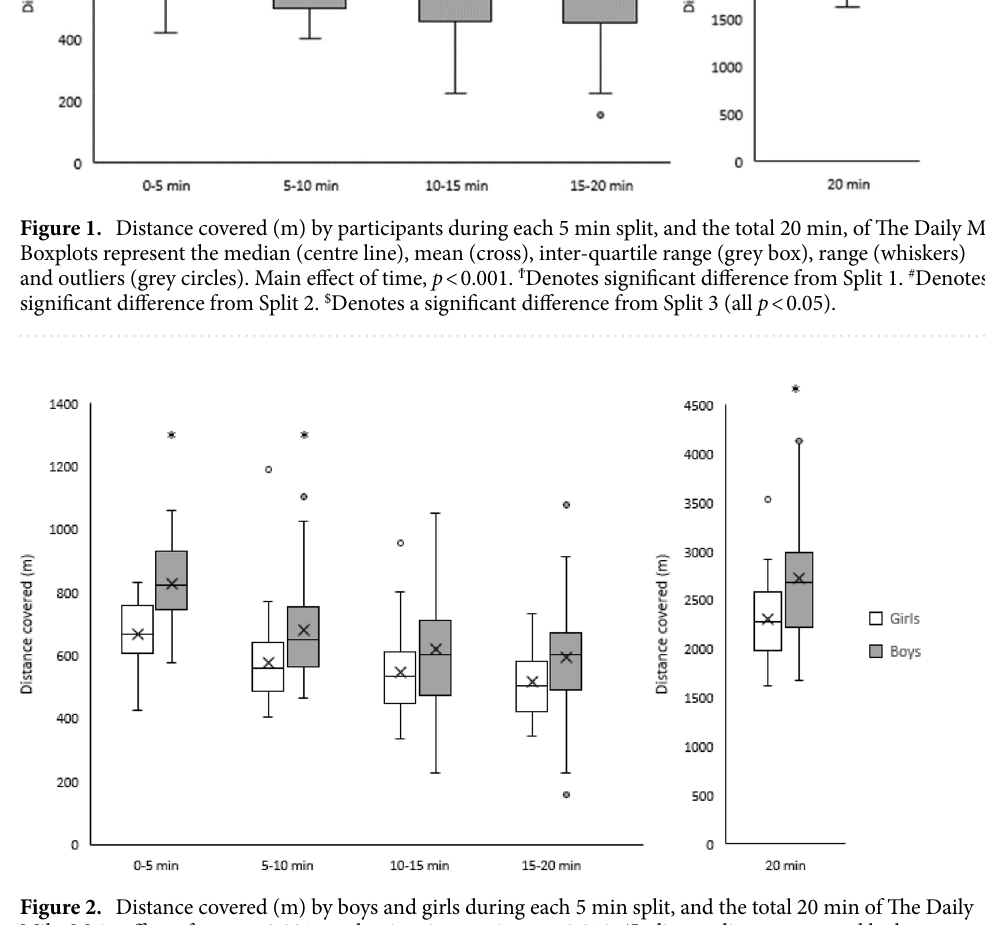
Figure 2. Distance covered (m) by boys and girls during each 5 min split, and the total 20 min of The Daily Mile. Main effect of sex, p = 0.001; sex by time interaction, p = 0.019. *Indicates distance covered by boys significantly greater than girls ( p ≤